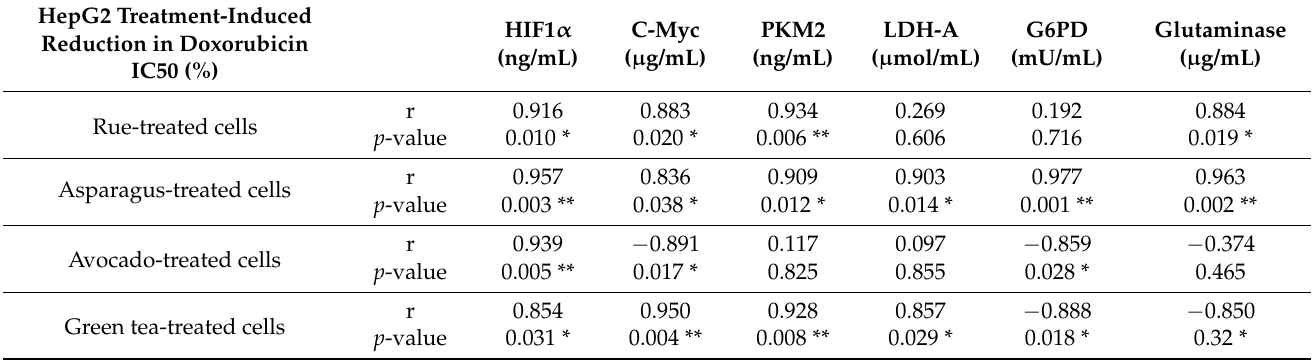
Table 3. Correlation between doxorubicin IC50 reduction (%) due to HepG2 cell pretreatment with four-candidate plant extracts and the decrease or increase in the metabolic proteins/enzymes level as compared to control untreated